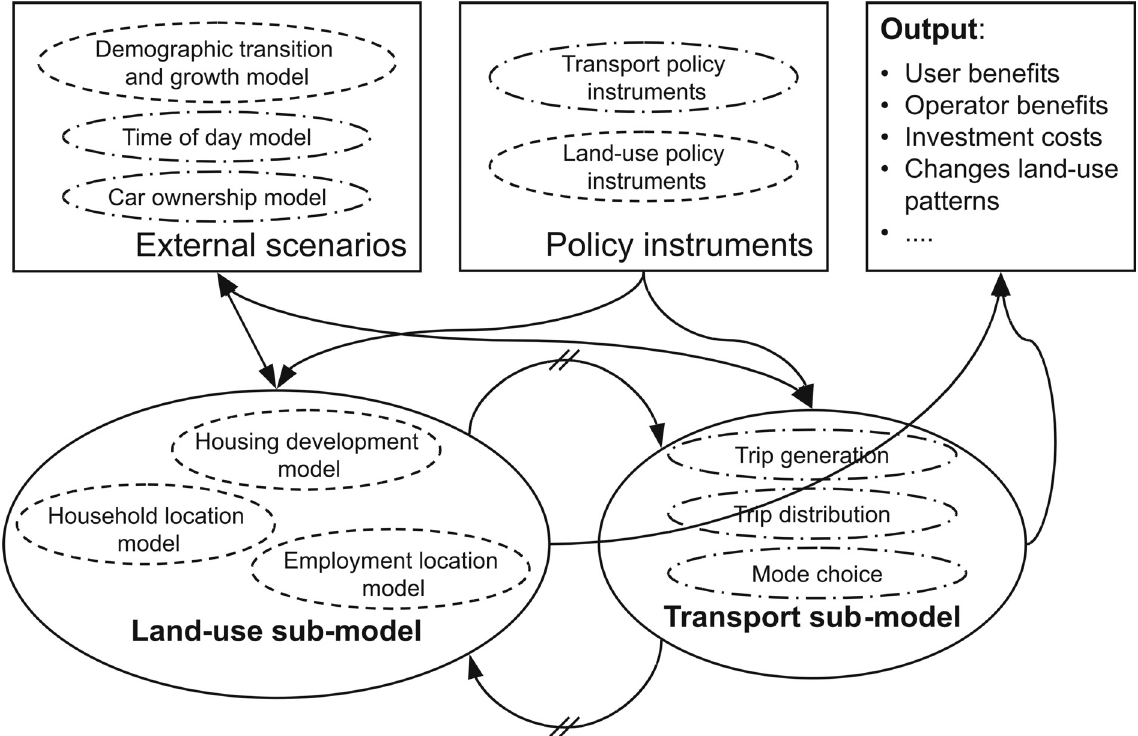
Figure 2: Development of the qualitative structure of the SPM using causal loop